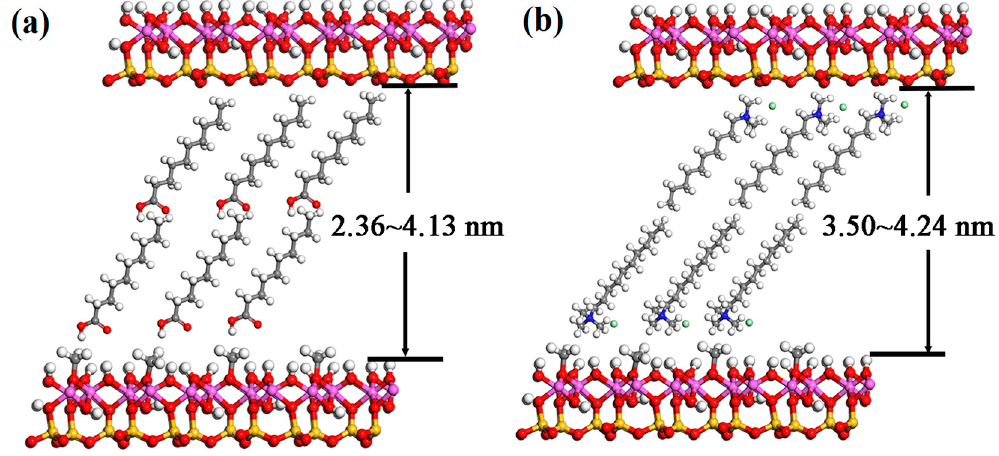
Figure 8. Schematic diagram of arrangement models of ( a ) kaolinite/fatty acid intercalation compounds (K-Fas), and ( b ) kaolinite/quaternary ammonium salts intercalation compounds (K-Qas).